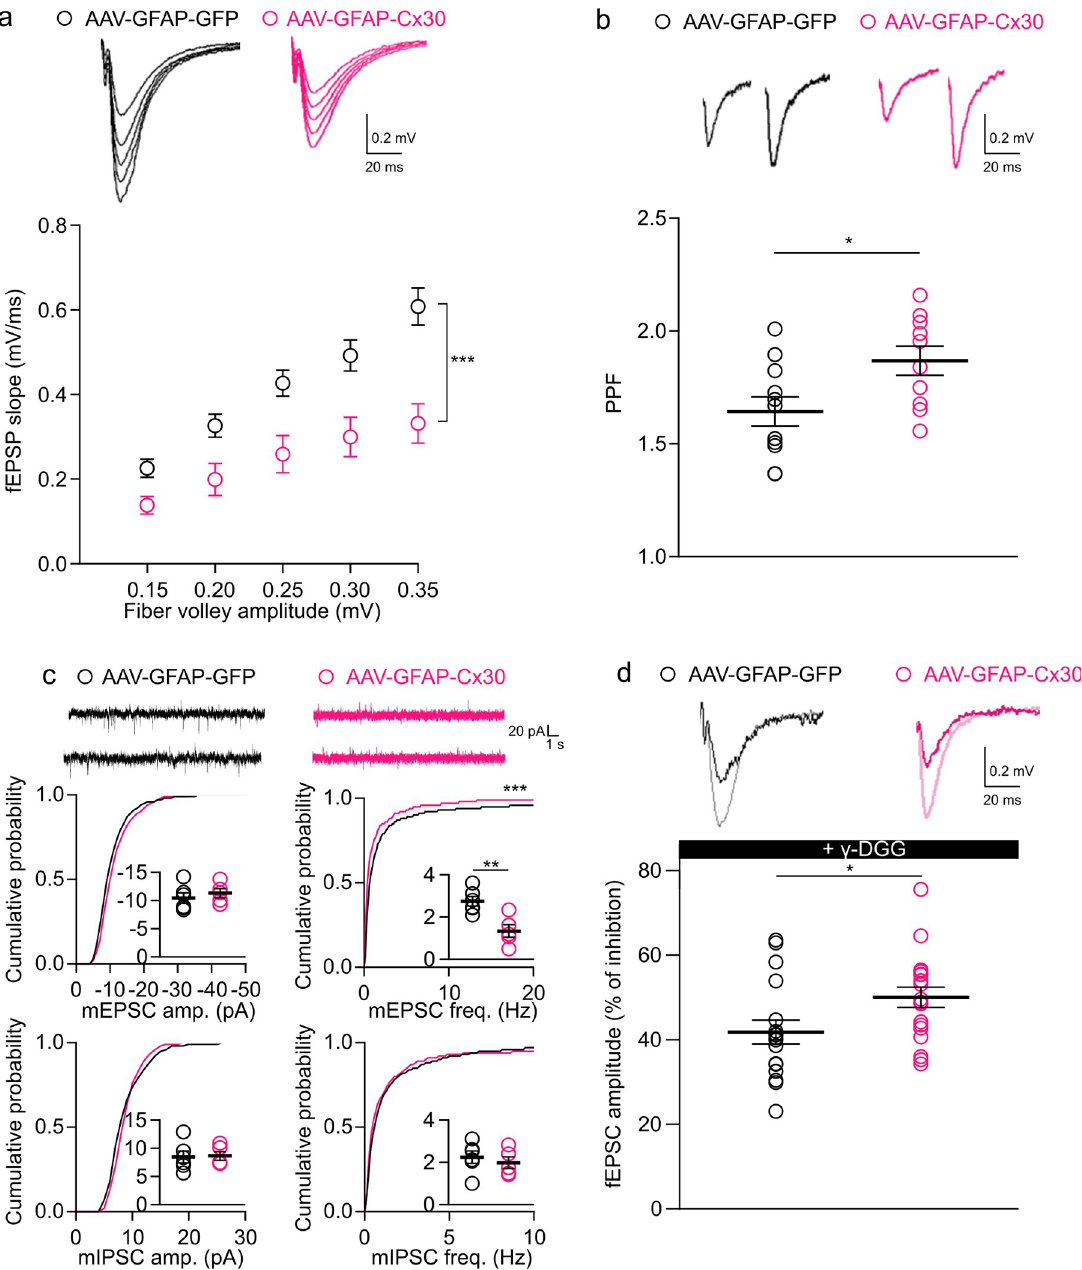
Fig 3. Cx30 upregulation in astrocytes alters excitatory synaptic transmission at CA1 Schaffer collateral synapses. (a) Input–output curves for basal synaptic transmission are illustrated in the sample traces and the graph below. fEPSP slope was decreased for AAV-GFAP-Cx30 ( n = 8 slices from 5 mice) compared to AAV-GFAP-GFP ( n = 7 slices from 5 mice; AAV: *** p < 0.001, F (1, 65) = 31,8; fiber volley: *** p < 0.001, F (4, 65) = 17,4, two-way ANOVA). ( b) PPF ratio (2 stimulations, interval 40 ms) and representative traces. PPF was increased for AAV-GFAP-Cx30 ( n = 11 slices from 5 mice) compared to AAV-GFAP-GFP ( n = 10 slices from 5 mice). p < 0.05, unpaired t test. ( c) (Upper) Sample traces from whole pyramidal cell recording. (Lower) Cumulative probability and mean values of mEPSCs and mIPSCs amplitudes and frequencies in both mice with AAV-GFAP-GFP ( n = 6 from 5 mice) or AAV-GFAP-Cx30 ( n = 5 from 5 mice). * p < 0.01, Mann–Whitney test, *** p < 0.001 K = 0.5466, Kolmogorov–Smirnov test. ( d) Synaptic glutamate levels revealed by γ -DGG (0.5 mM) inhibition of EPSC amplitude were reduced in mice with AAV-GFAP-Cx30 mice ( n = 19 slices from 6 mice) compared to mice transduced with AAV-GFAP-GFP ( n = 17 slices from 5 mice). Individual numerical values are indicated in S1 Data. * p < 0.05; Mann–Whitney test. AAV AU : AbbreviationlistshavebeencompiledforthoseusedinFigs 3 (cid:0) 6 : Pleaseverifythatallentriesarecorrectlyabbreviated : , adeno-associated vector; EPSC, excitatory postsynaptic current; fEPSP, field excitatory postsynaptic potential; mEPSC, miniature excitatory postsynaptic current; mIPSC, miniature inhibitory postsynaptic current; PPF, paired pulse facilitation; γ -DGG, γ -D-glutamylglycine.